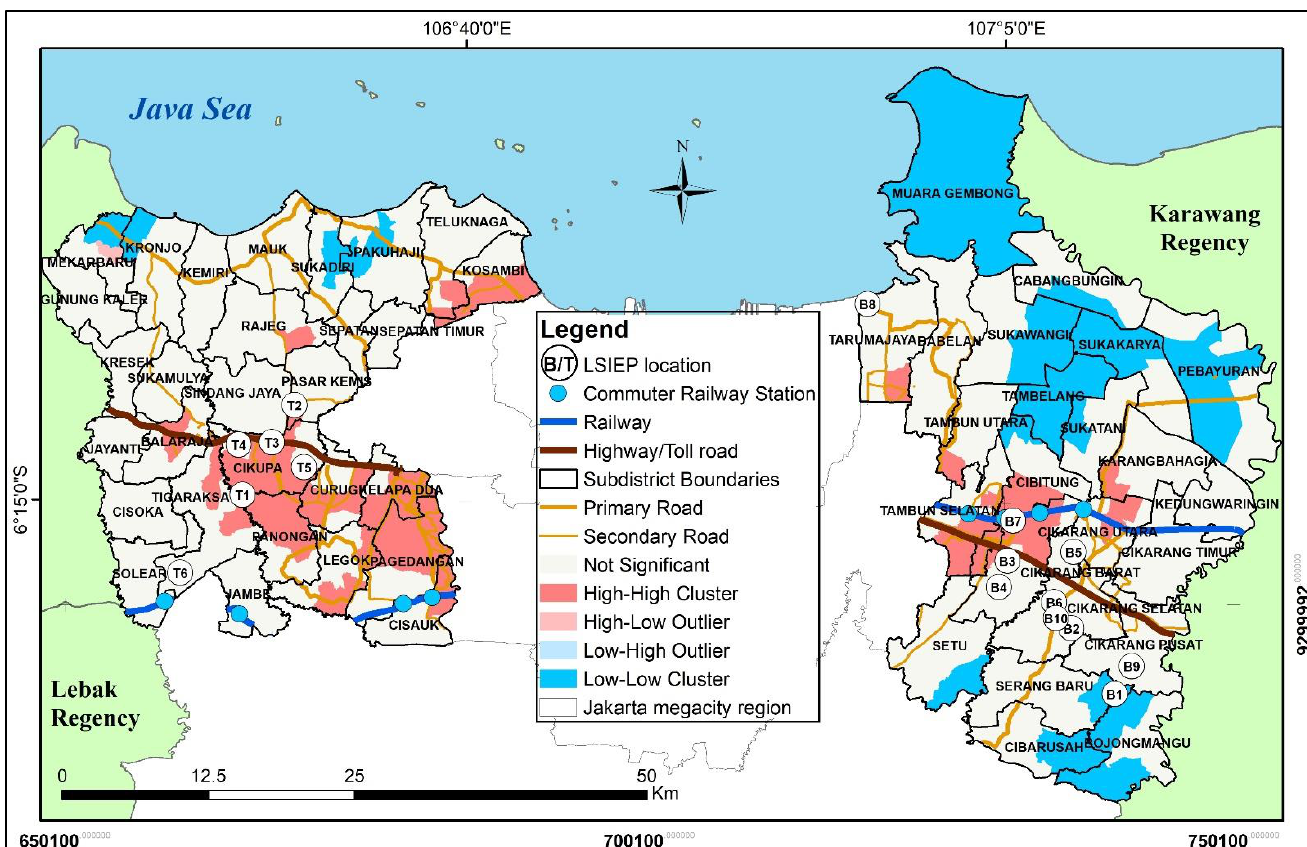
Figure 9. LISA Map of 2005 – 2015 RULT Index value difference.